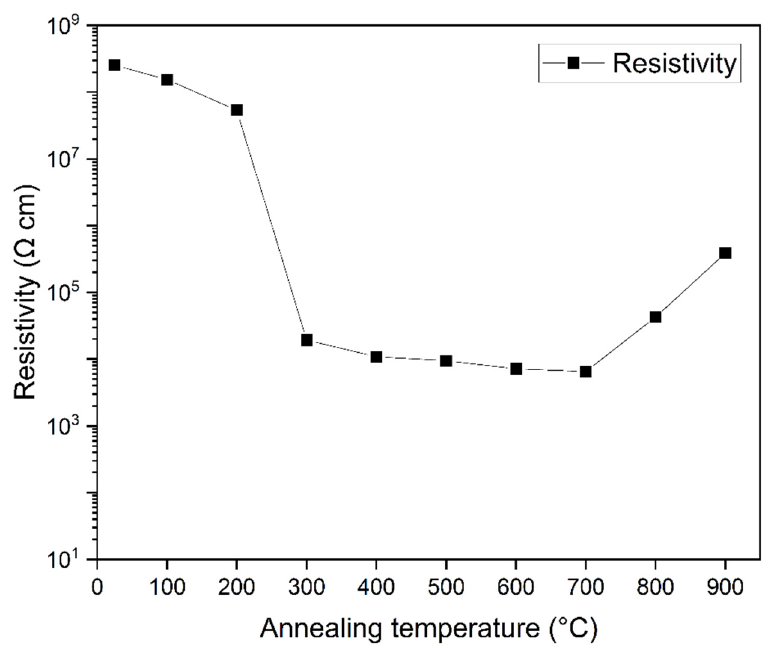
Figure 8. Influence of the annealing temperature on the electrical resistivity.